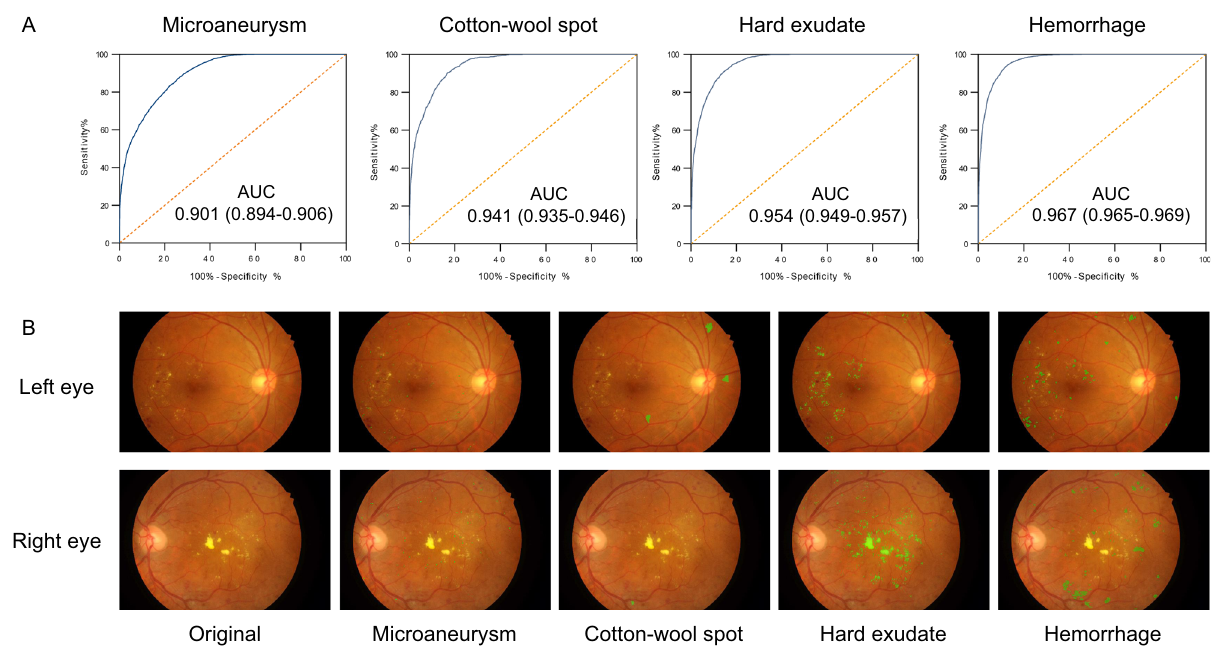
Fig. 3 Performance of the lesion-aware sub-network. A Receiver operating characteristic curve demonstrating the performance of the lesion-aware sub- network for retinal lesion detection ( n = 4621). B Example images of retinal lesion segmentation: microaneurysms, cotton-wool spots, hard exudates, and hemorrhages are highlighted using green regions.